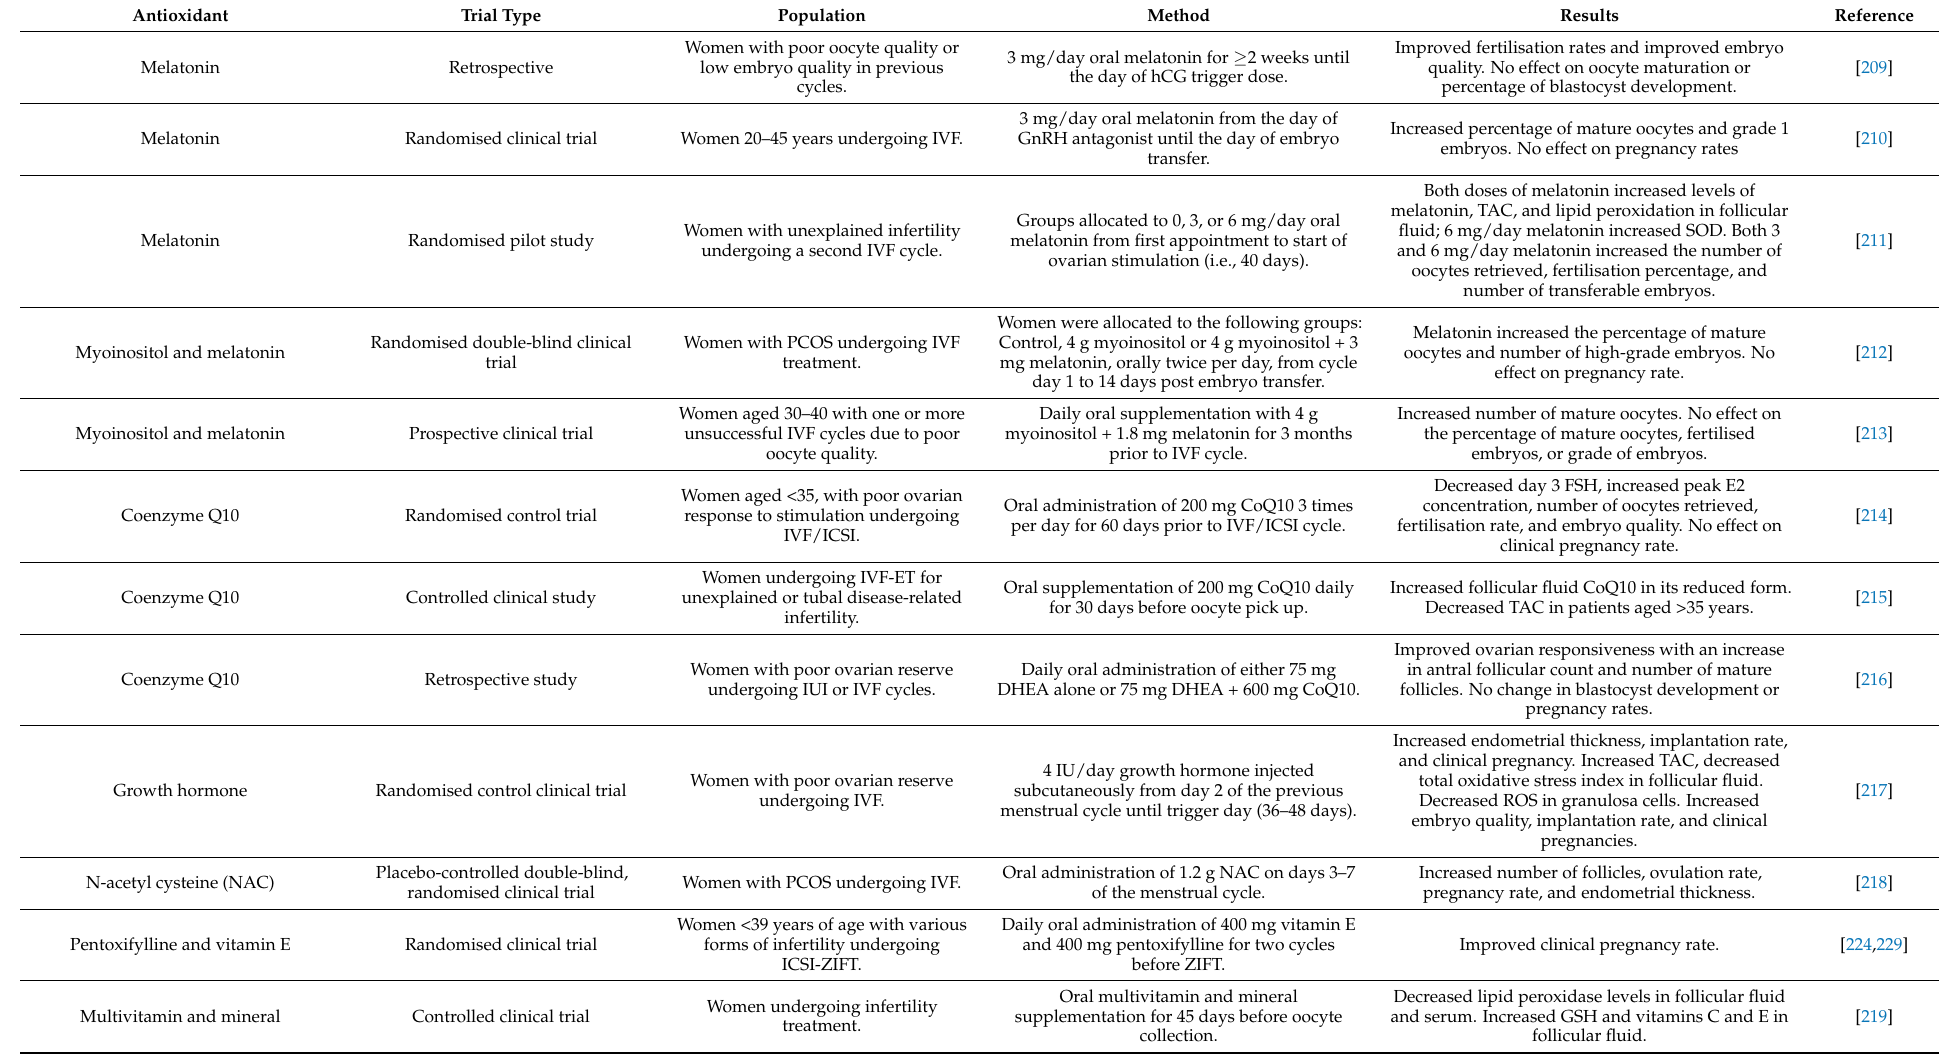
Table 1. Clinical trials using antioxidants, taken orally, in patients undergoing infertility treatment, and their effect on oocyte, sperm, and embryo